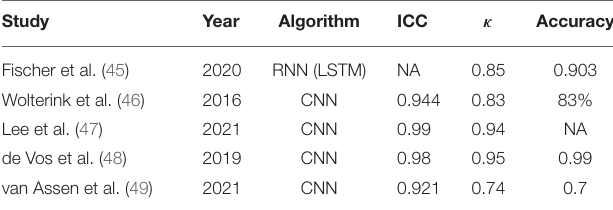
TABLE 4 | Application of artificial intelligence in automatic coronary calcium